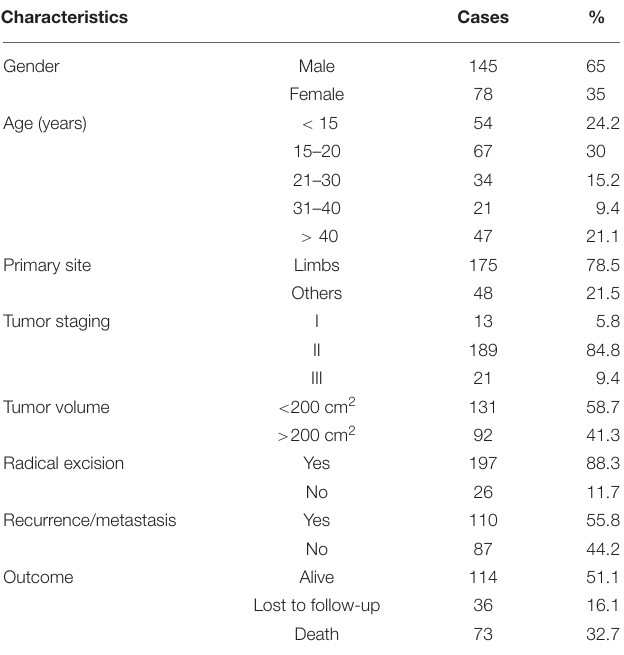
TABLE 1 | Clinicopathological characteristics of osteosarcoma patients.